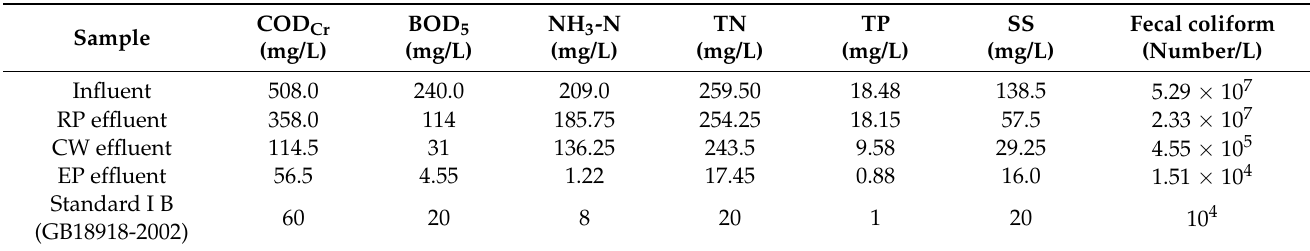
Table 2. Average concentrations of the main indicators in the influent water and effluent water of each treatment stage.